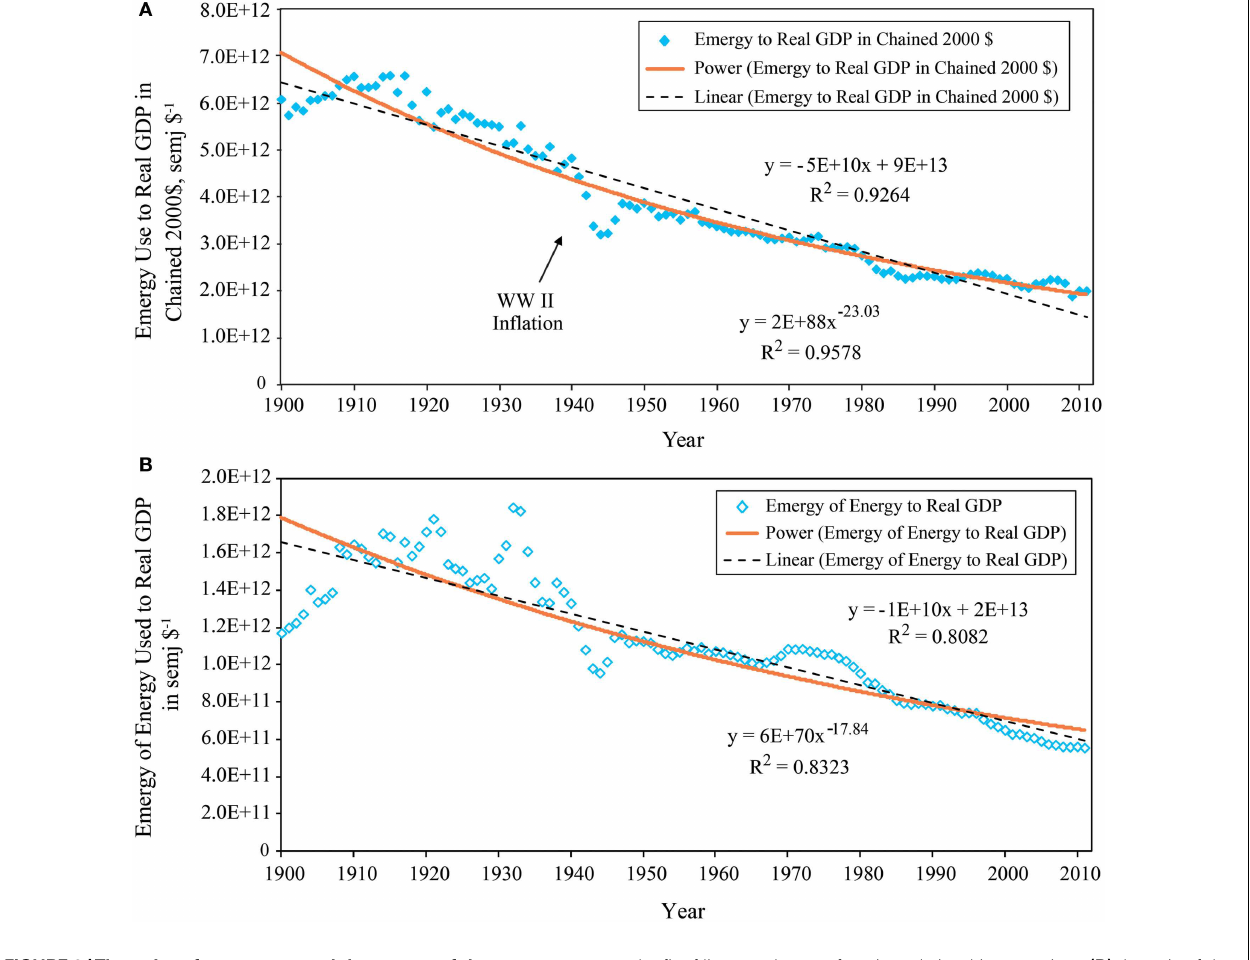
FIGURE 9 |The ratios of emergy use and the emergy of the energy consumed to real GDP of the U.S. economy from 1900 to 2011 are shown . (A) The ratio of emergy use to real GDP in chained 2000 $ showing